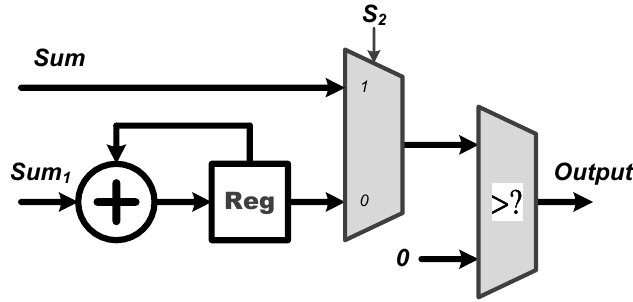
Figure 4. Architecture of the proposed ReLU module.